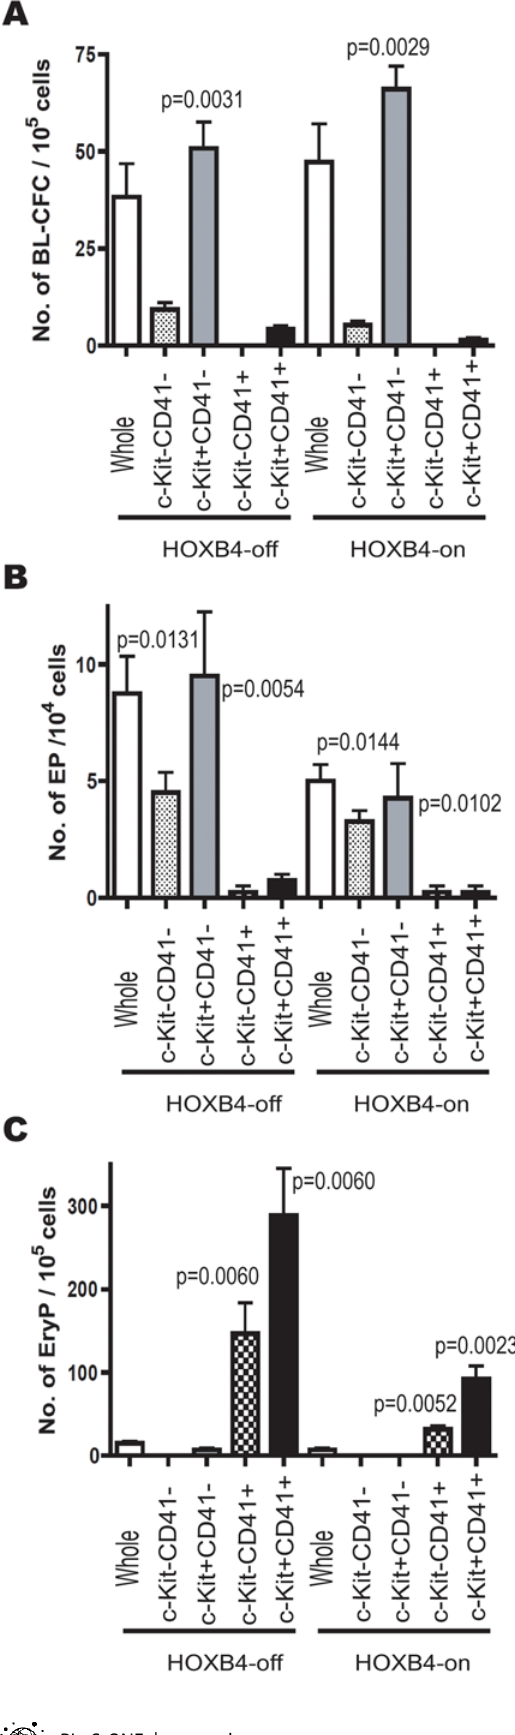
Figure 3. Hemangioblastic, endothelial, and primitive erythro- cytic potentials among EB6 subpopulations. Colony forming abilities in unfractionated, c-Kit 2 CD41 2 , c-Kit + CD41 2 , c-Kit 2 CD41 + , or c- Kit + CD41 + EB6 cells were examined in quadruplicate. (A) Blast colony- forming assays were performed. (B) Vascular endothelial progenitors (EP) were detected by the OP9 co-culture system with cytokines as previously described [20]. (C) Erythroid colonies were detected by methylcellulose colony assays. Detected erythroid colonies contained primitive erythrocytes as identified by b -H1 globin expression (data not shown). Kruskal-Wallis testing was performed for statistical